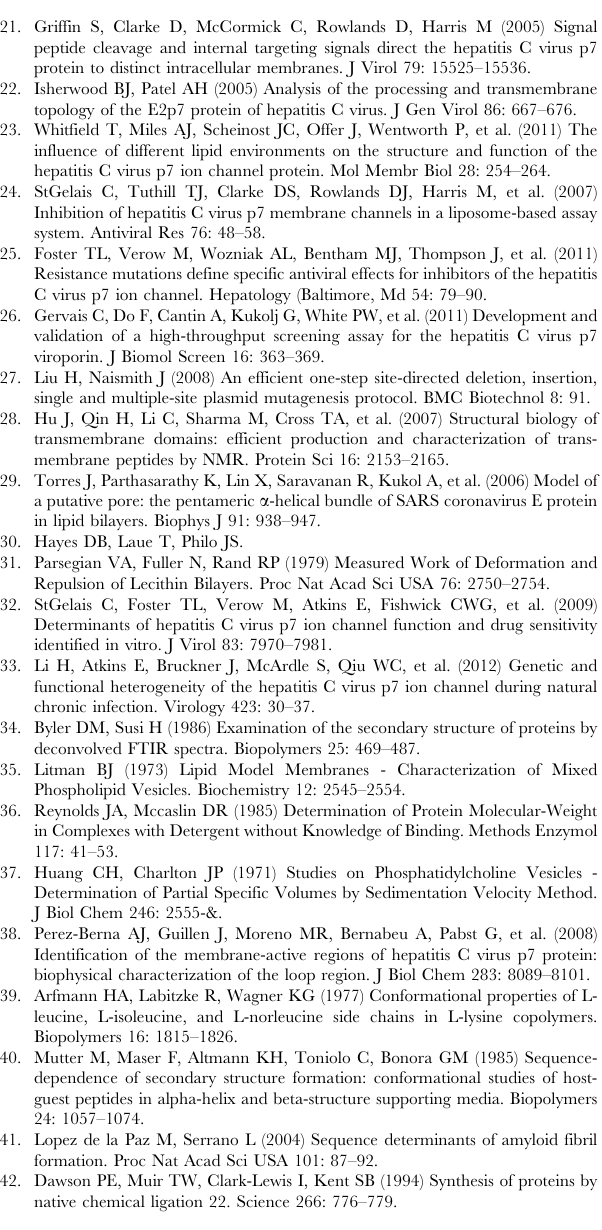
NMR experiments. Both sequences correspond to genotype 1b but regions that span TM1 and TM2, and the loop region that indicated. Differences in the sequences are indicated by a